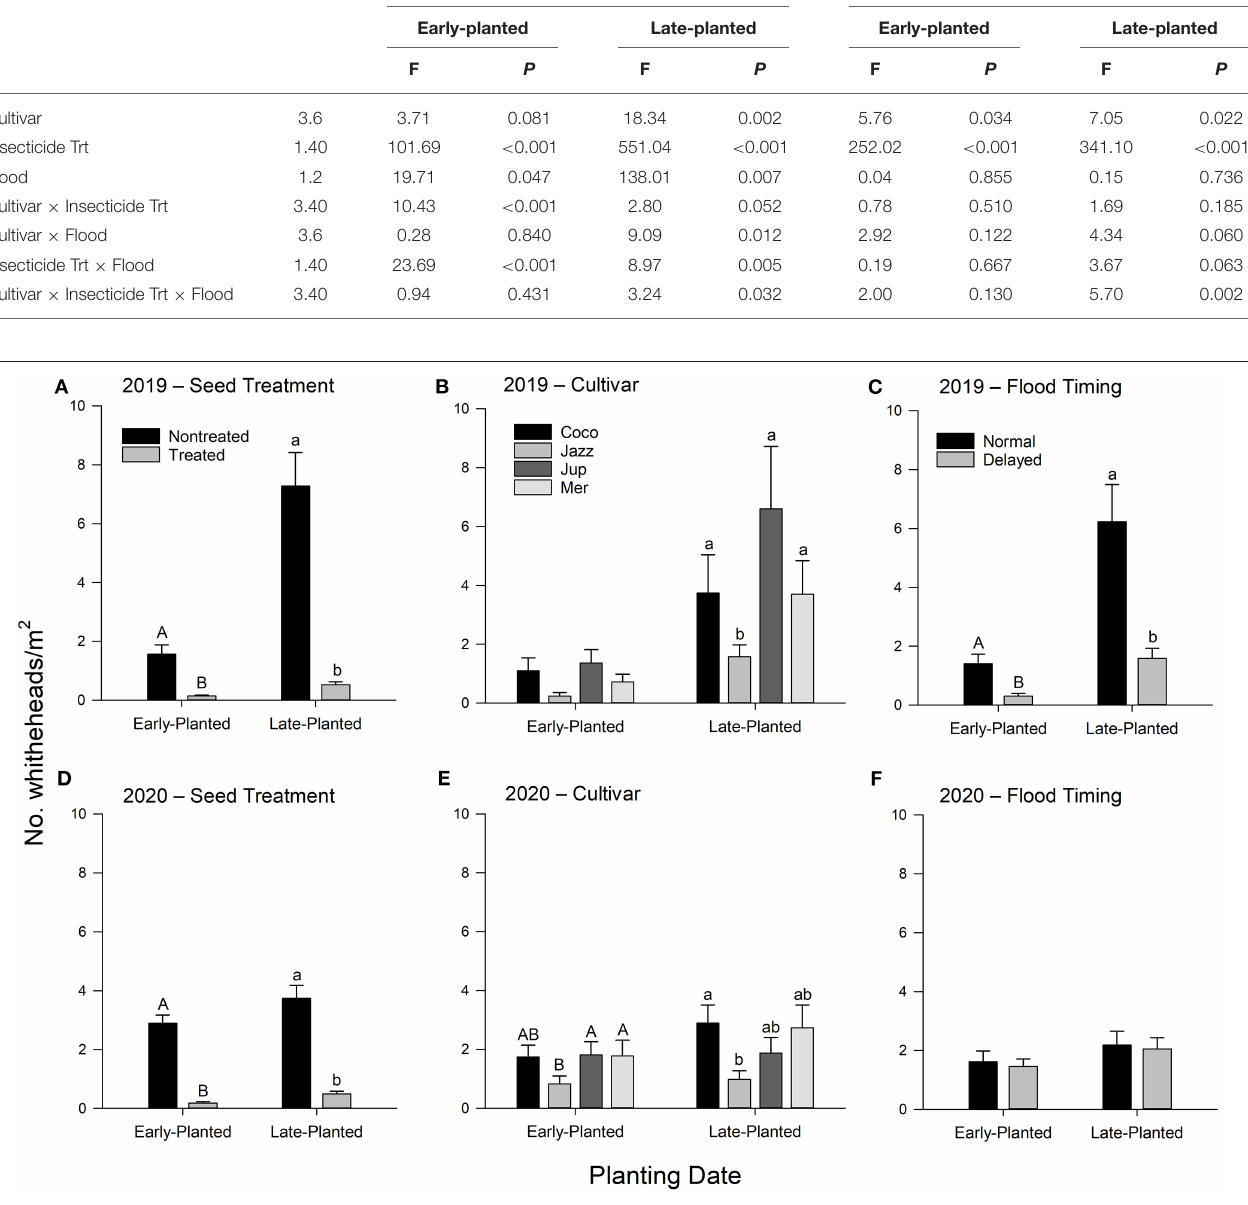
FIGURE 3 | Mean ( + SEM) whitehead (blanked panicles) densities as affected by (A,D) insecticidal seed treatment, (B,E) rice cultivar, and (C,F) flood timing main effects, Crowley, Louisiana, 2019–2020. Analyses were conducted separately by year and planting date. Bars accompanied by the same letter do not differ significantly (Tukey’s HSD: α >